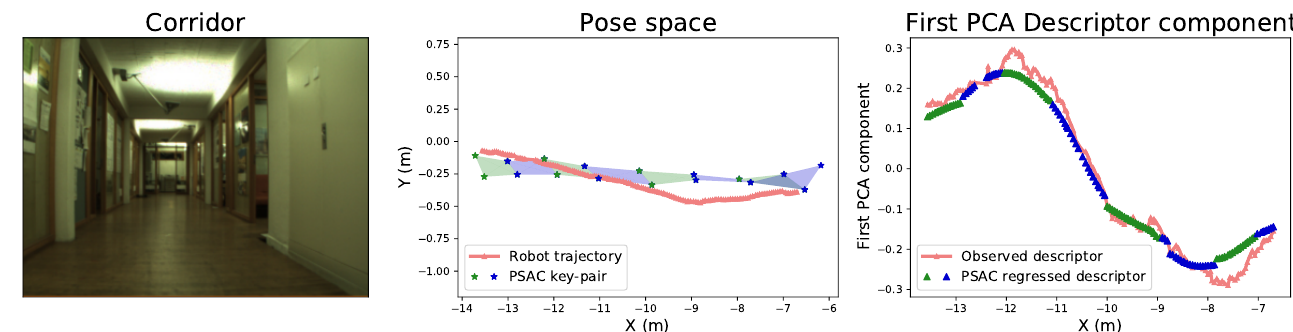
Figure 5. Experimental study of the global image descriptor behavior along a corridor of the COLD-Freiburg database (left image). The central figure depicts the robot pose trajectory and the PSACs (shadowed areas) through which it navigates. The rightmost figure compares, along the corridor, the behavior of the first Principle Component Analysis (PCA) component of the observed descriptor (coral) and the PSAC regression output (blue and green). This is better seen in color.